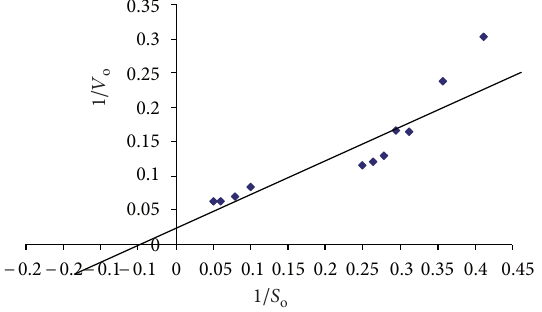
of F. solani PHB